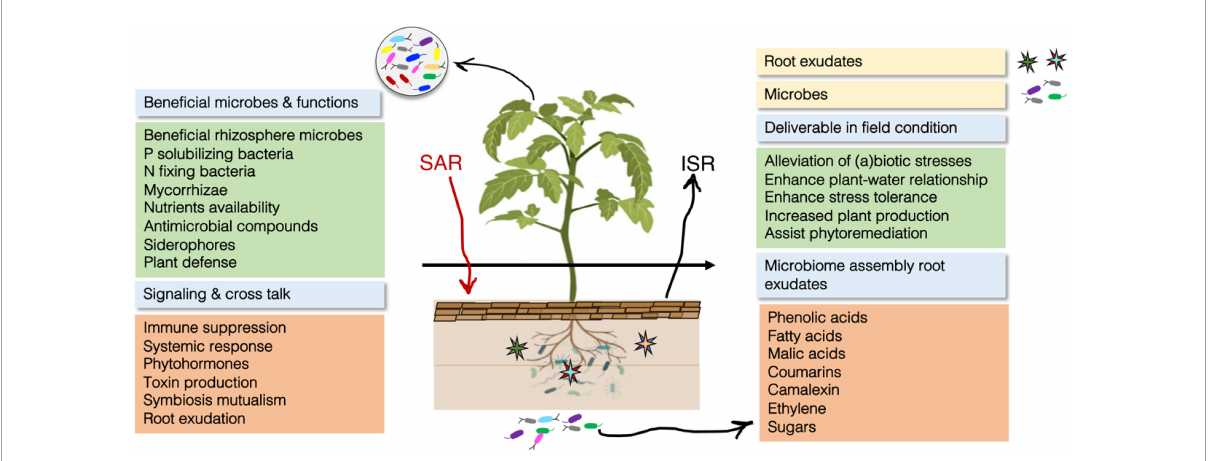
FIGURE1 The holistic overview of plant microbiome compositions, the interaction between plant and its associated microbes, function and its positive effect on plant growth and development under extreme conditions. Plant recruit and assembly beneficial microbes via exudation and constitute a healthy and beneficial microbial community. This microbiome improves plant health, alleviates abiotic stresses and provides a safeguard to the host exhibiting various direct and indirect